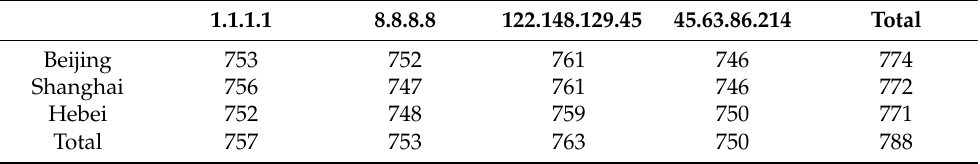
Table 6. The number of forged IP addresses contained in DNS resolver responses.